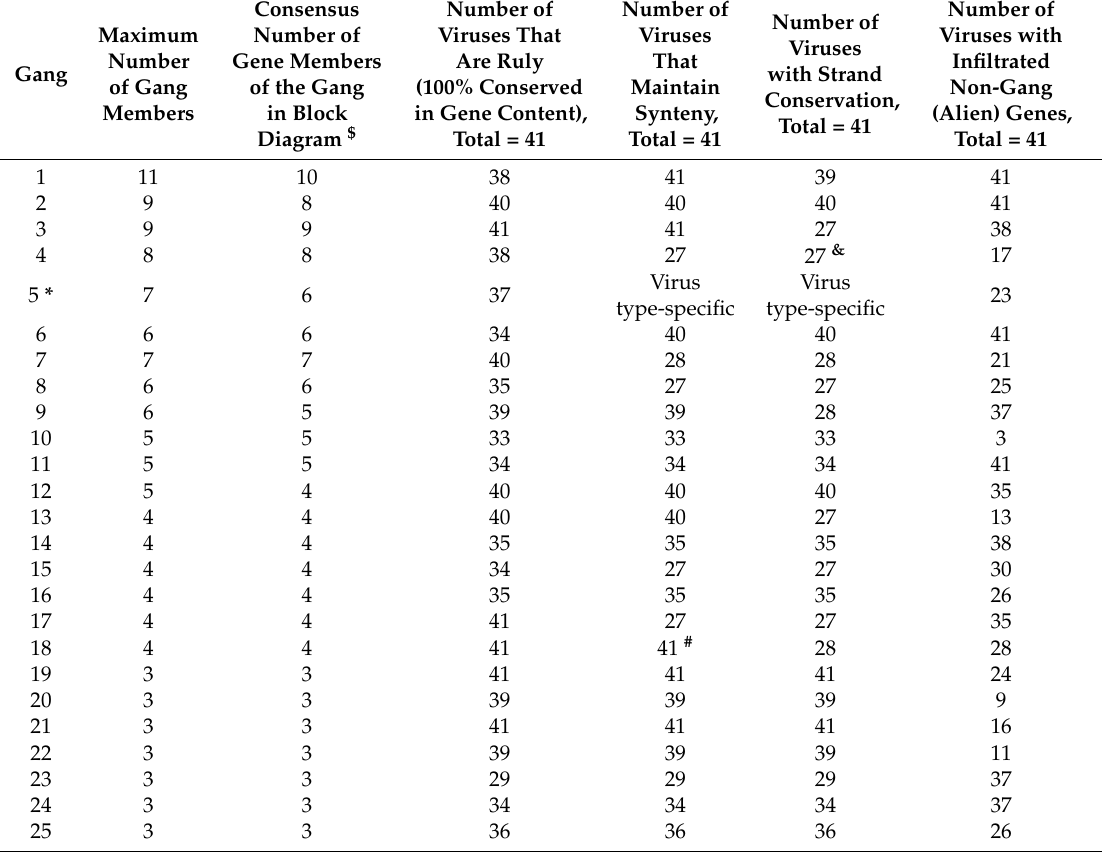
Table 2. Chlorovirus gene gangs—conservation of gene content, synteny, strandedness, and the frequency of alien gene